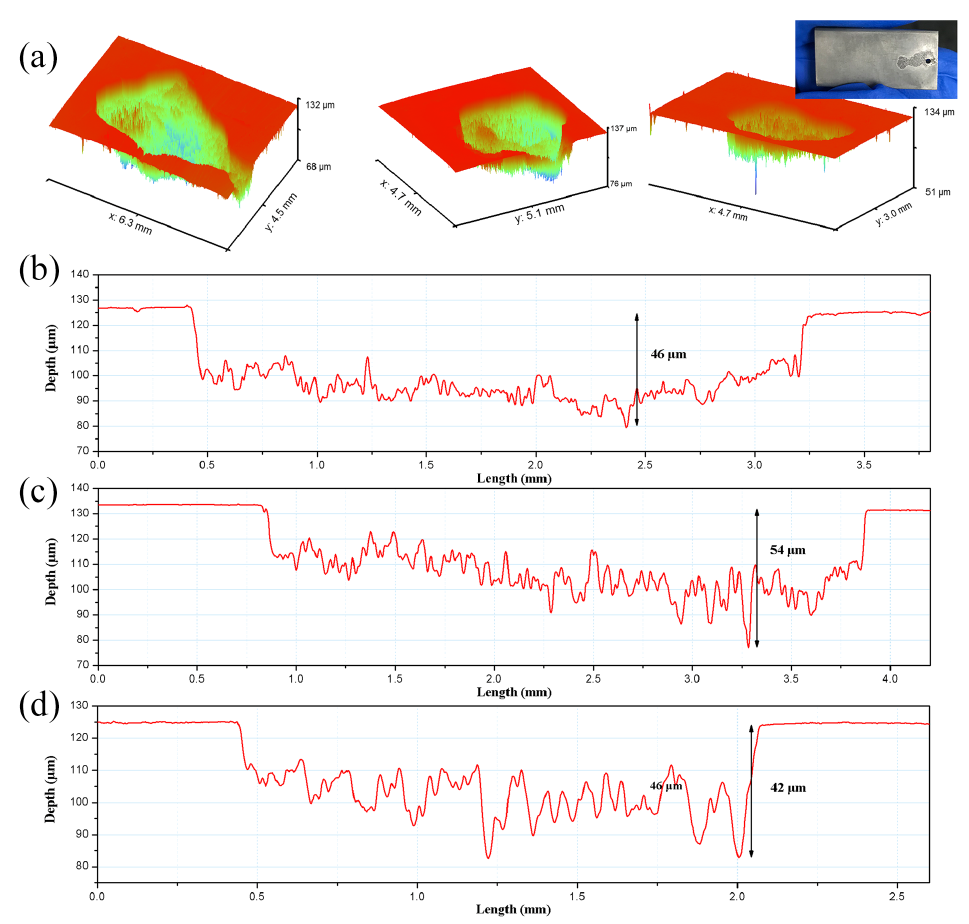
Figure 4. ( a ) 3D morphologies of the corrosion pits and ( b – d ) pits depth of the Q235 coupon after immersion corrosion test in SRB-Z solution for 7 days.